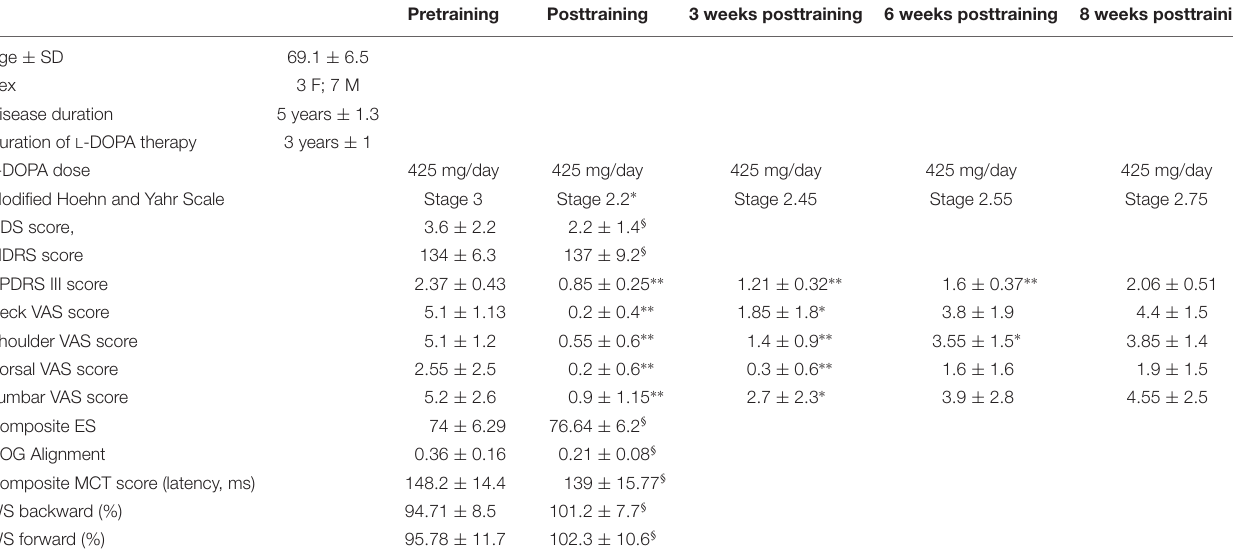
TABLE 1 | Demographic data and some clinical, EquiTest, and neurocognitive data of the 10 Parkinson subjects, before and after the training with Angel’s